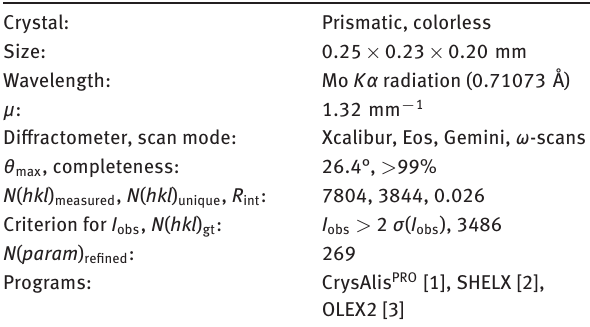
Table 1: Data collection and